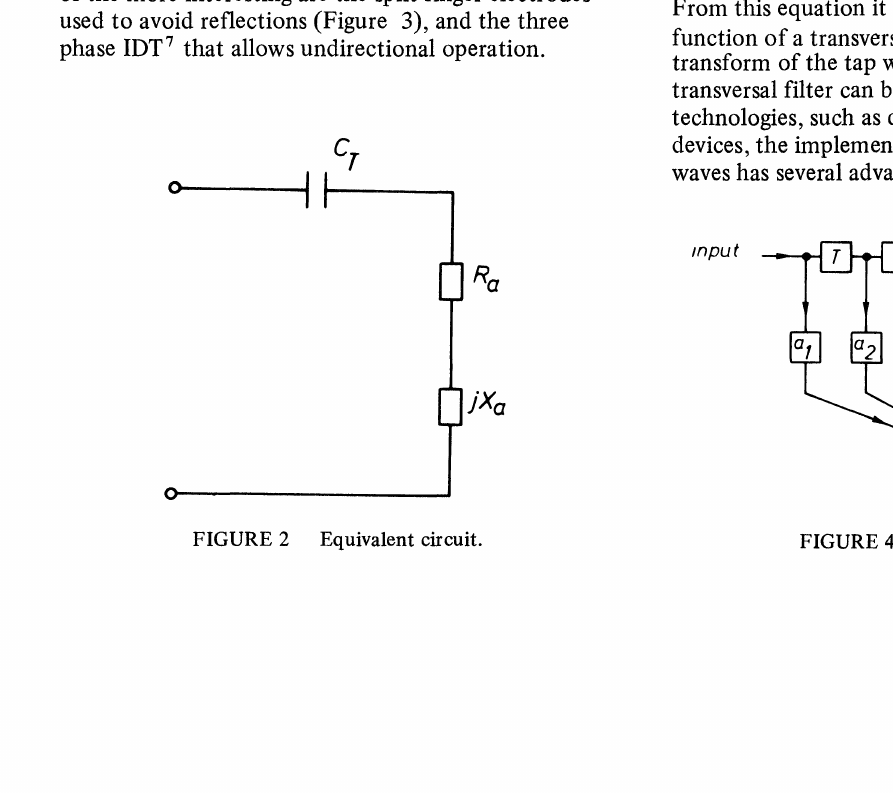
FIGURE 4 Transversal